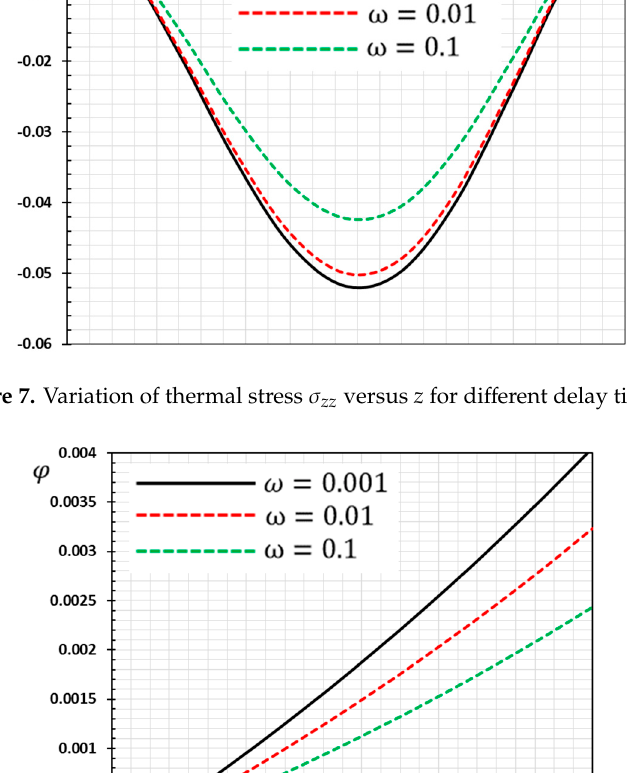
Figure 6. Variation of displacement 𝑤 versus 𝑧 for different delay time 𝜔 .